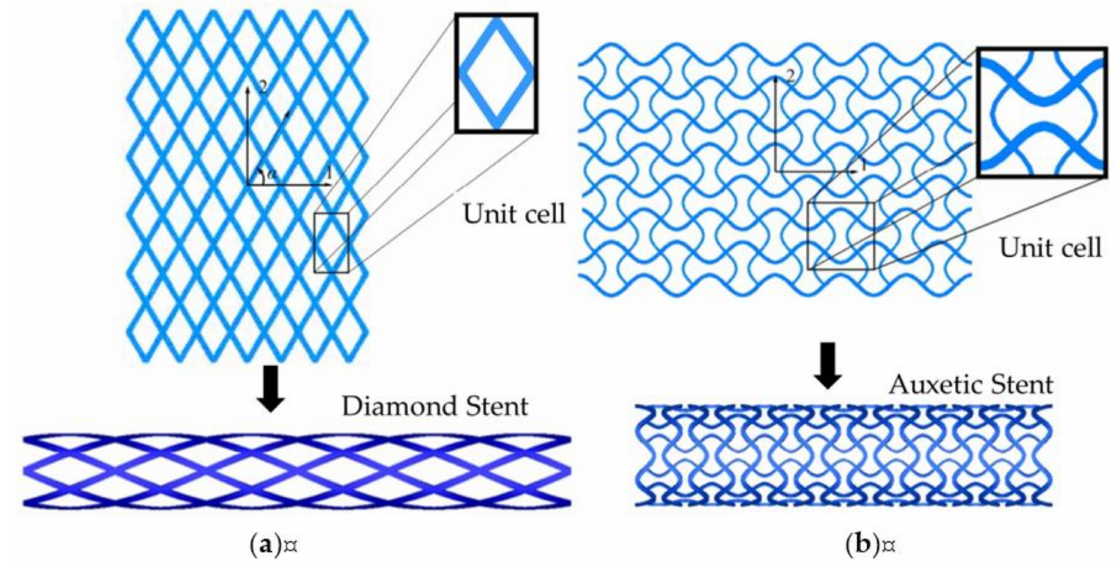
Figure 14. Two-unit cell of stents [110]: ( a ) Diamond stent; ( b ) Auxetic stent.